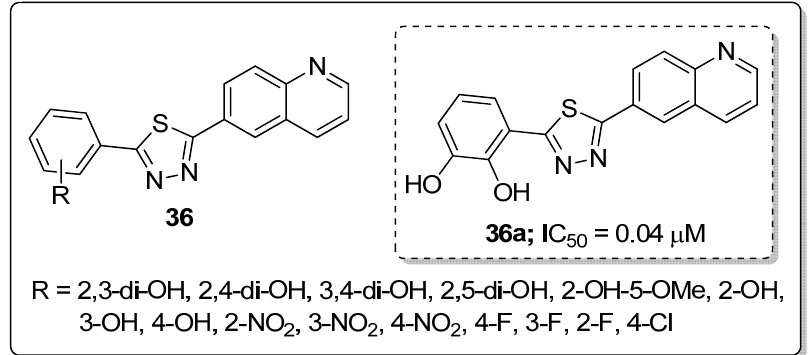
Figure 41. The antileishmanial potential of the most active quinoline ‐ thiadiazole hybrid 36a .